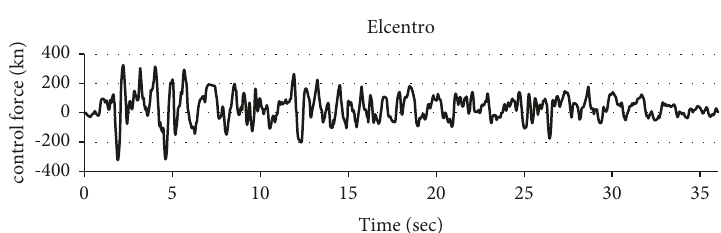
Figure 19: The control force in AP-TMD in Elcentro earthquake.